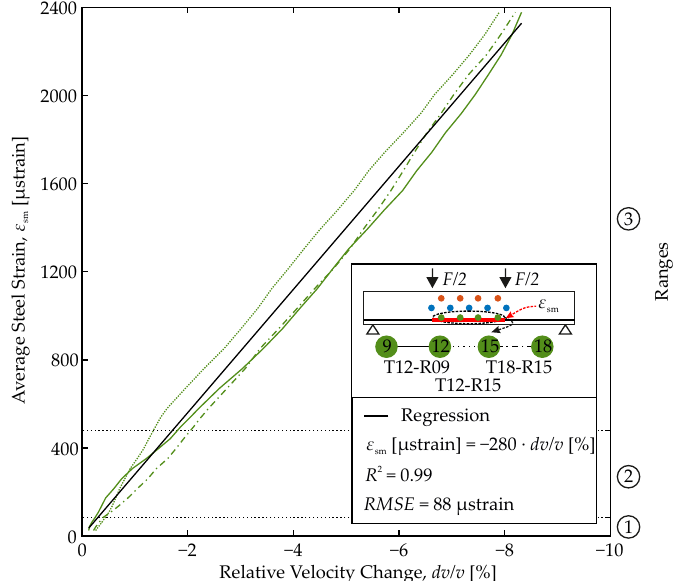
Figure 8. Correlation of average steel strain to relative velocity